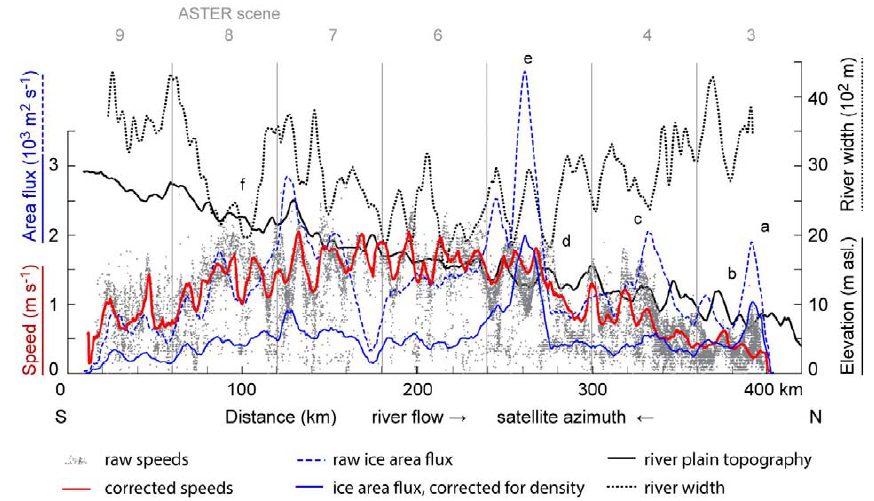
Fig. 6. Along-track profile of ice speeds, ice area fluxes, river width and river plain elevation; 4.5km running means for speeds, topography and width, 9km for area fluxes. Ice speeds (red) are given without (dashed) and with stable ground offsets corrected (solid). Ice area fluxes are calculated as a product of ice speed and cross-section width that contains ice debris (blue dashed). Ice area fluxes are also corrected for ice density as obtained from the reflectance variations in the ASTER scenes (solid blue). River plain elevation is interpolated from a DEM compiled from the ASTER GDEM and Russian topographic maps (www.viewfinderpanoramas.org). Lower-case letters indicate the location of sites of Figs. 4, 7 and 8.